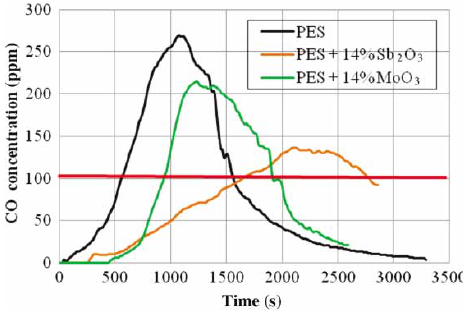
Fig. 14. CO concentration time series registered by C1 sensor located at the corner of the compartment (post C) at 1.6 m for three studied samples